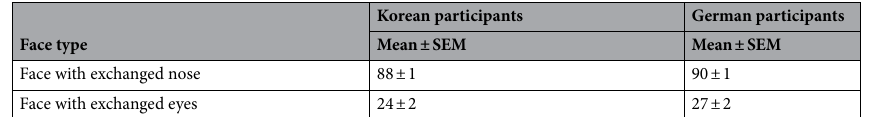
Table 3. Mean ethnicity choices for the parent race in percent and standard error of the mean (SEM) calculated for each participant group for faces with exchanged nose or eyes.